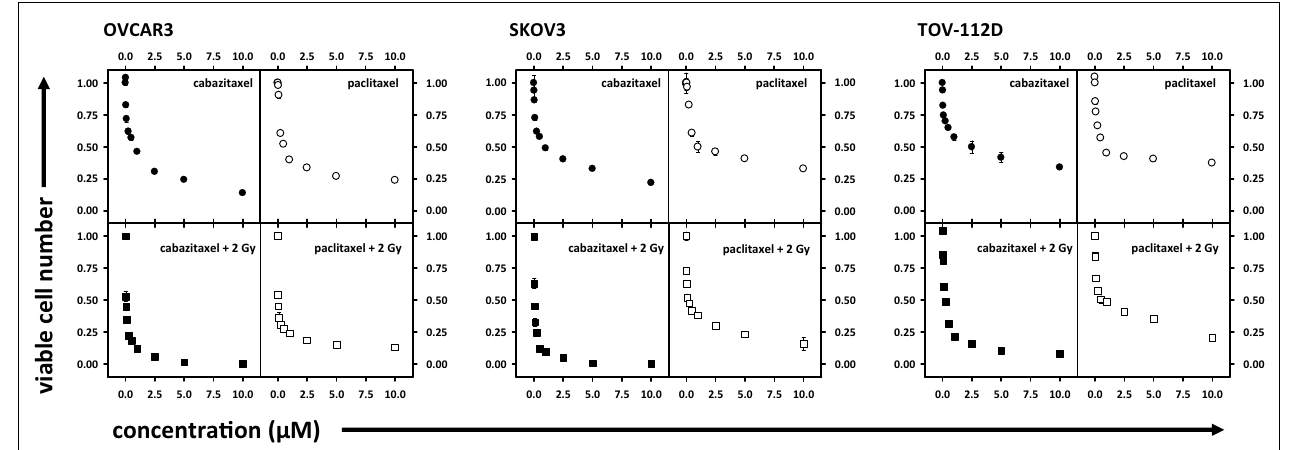
FIGURE 1 | Depicted are cell viability assays (MTT) in OVCAR3, SKOV3, andTOV-112D ovarian cancer cells . Radiation (2Gy), cabazitaxel, or paclitaxel treatments are indicated. Means and standard errors are